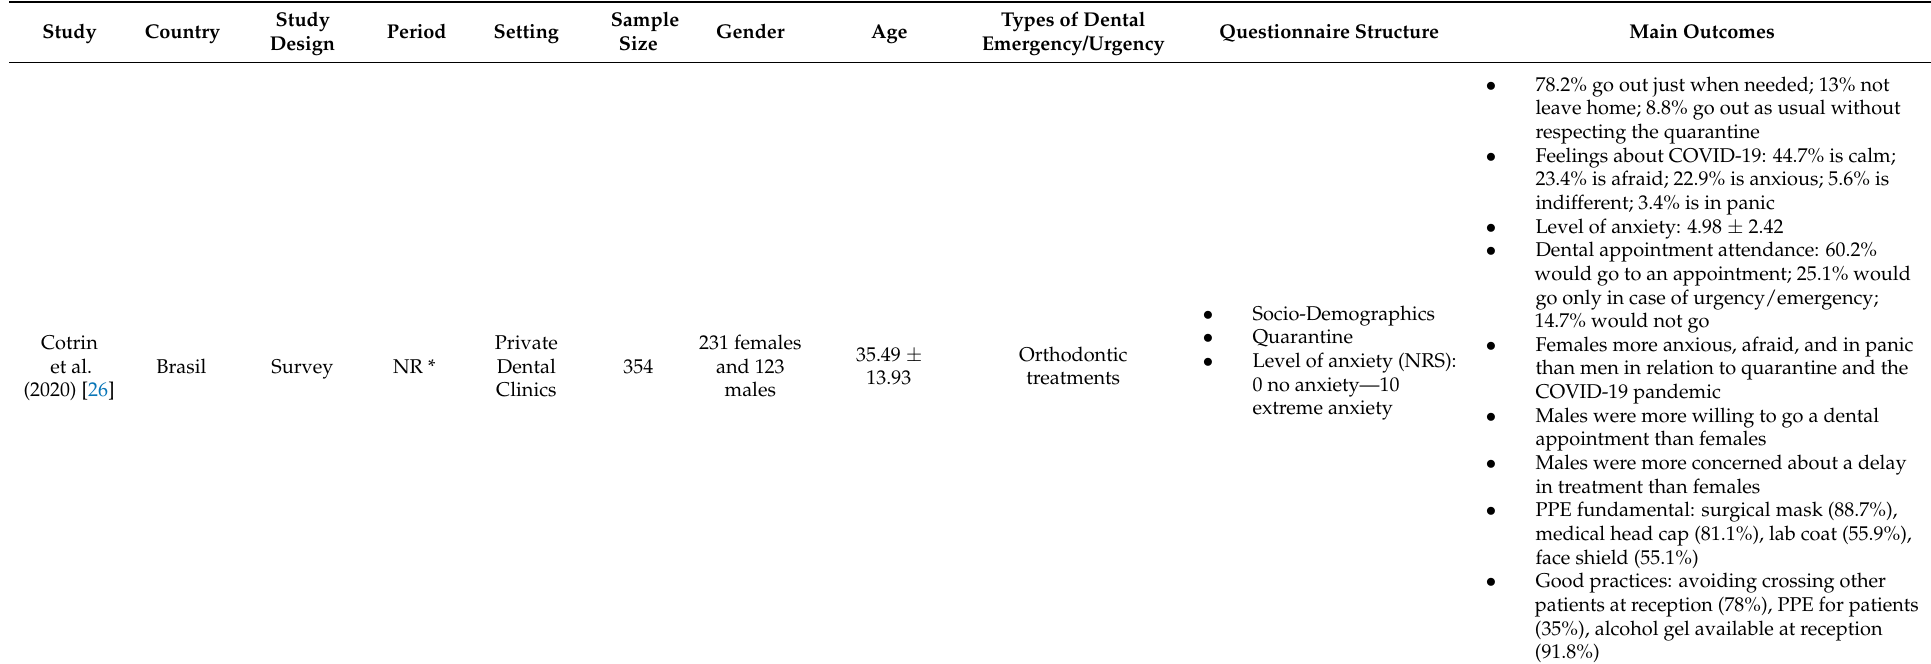
Table 1. Studies